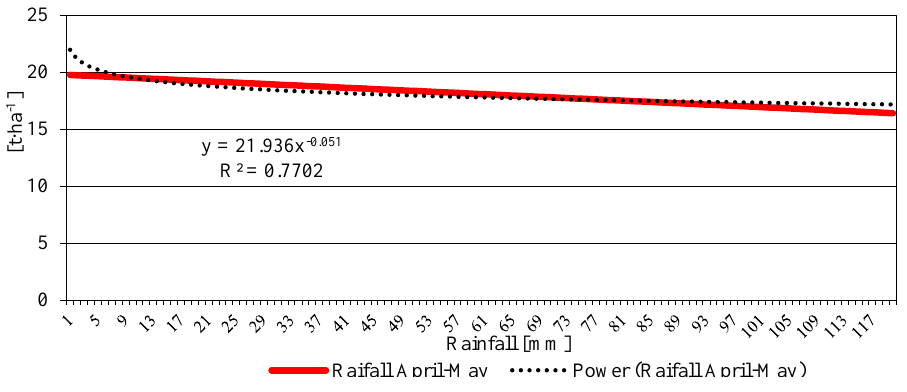
Figure 7. Partial dependence and potato tuber yield on air temperature in August – September.